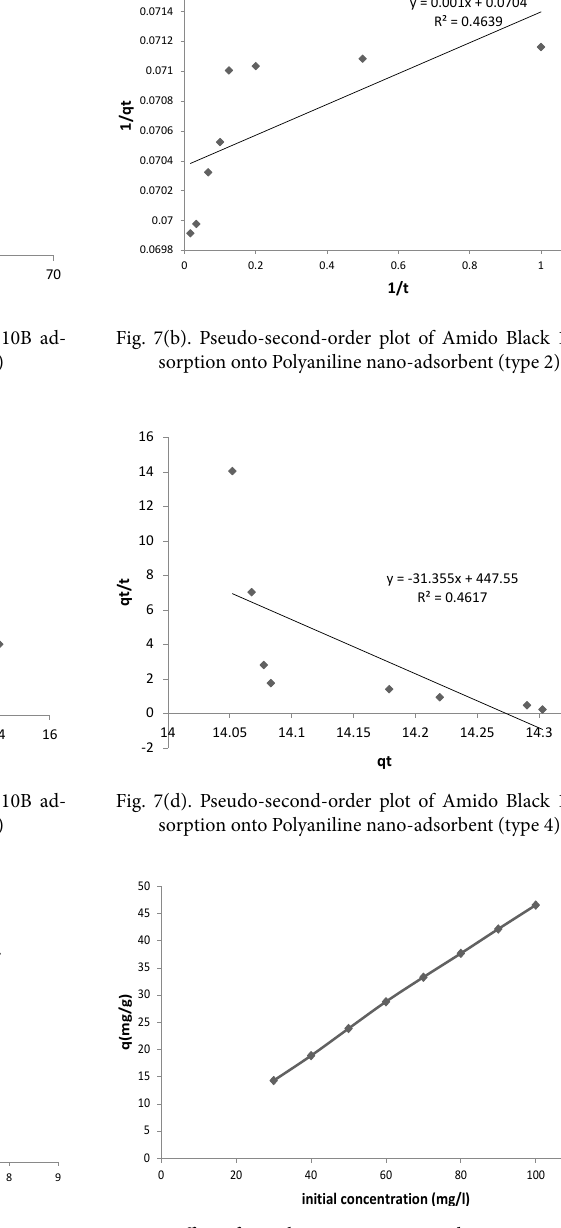
Fig. 8. Weber-Morris plot of Amido Black 10B adsorption onto Polyaniline nano-adsorbent Fig. 9. Effect of initial concentration on adsorption capacity of Amido Black 10B dye onto Polyaniline